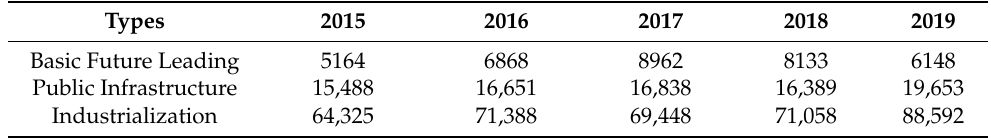
Table 5. Revenue from technical fees by GRI mission type